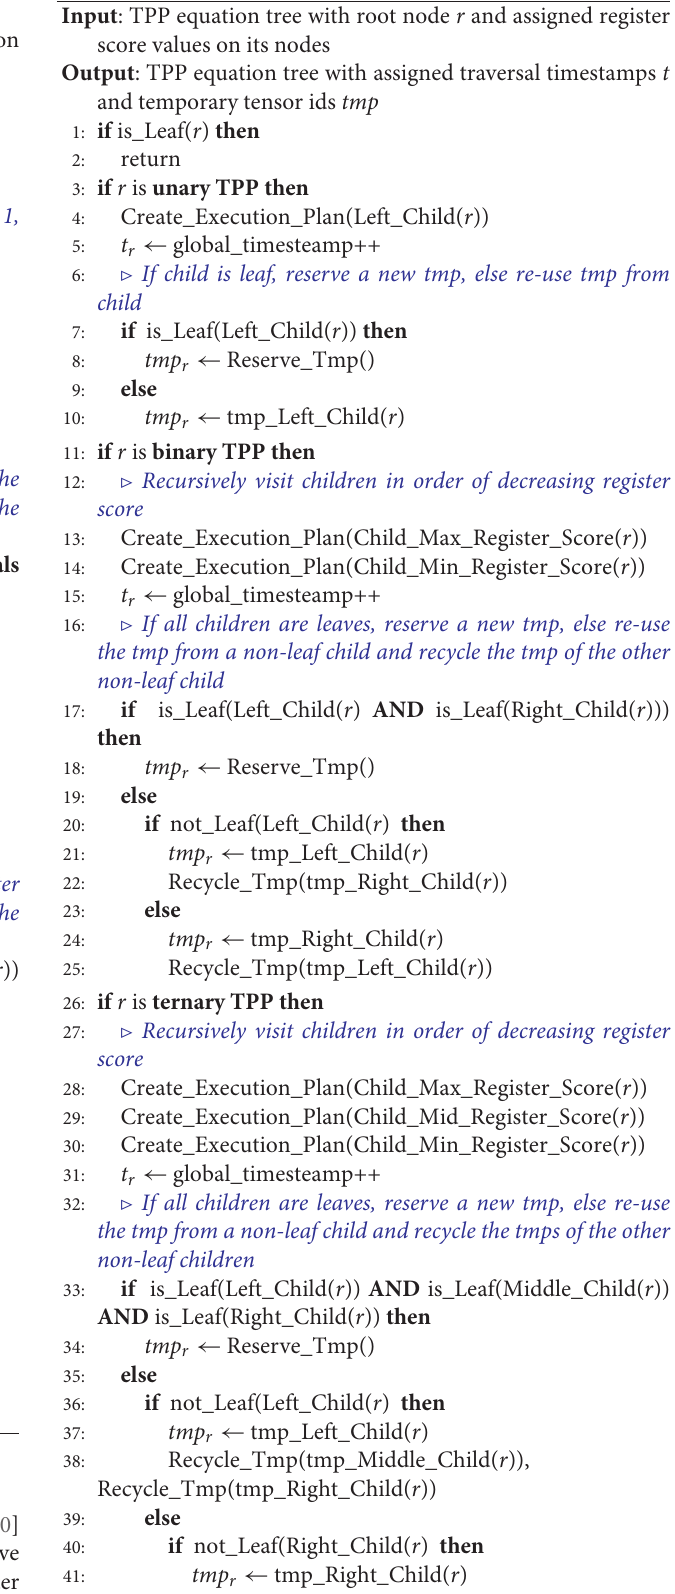
Algorithm 3 . This algorithm calculates recursively the